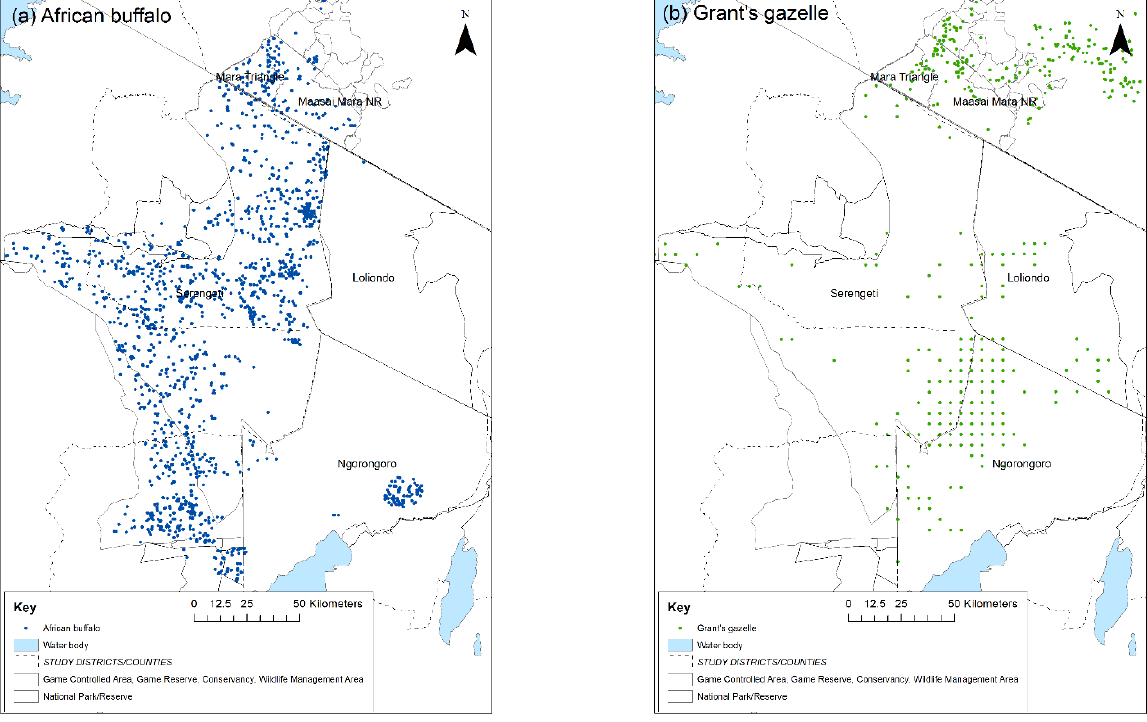
Figure 2. Wet season distribution of: ( a ) African buffalo; ( b ) Grant’s gazelle in the Greater Serengeti ecosystem, 2014. Source of data: Tanzania Wildlife Research Institute and Kenya Wildlife Service aerial surveys and census data. Dots represent sightings of one or more animals: blue = African buffalo, green = Grant’s gazelle .